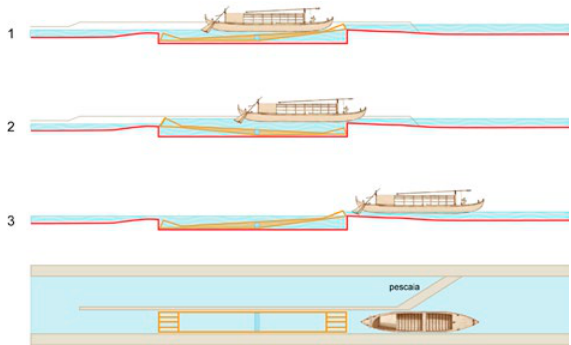
Figure 29. Operation of the rocker arm system designed to support one braccio of water.